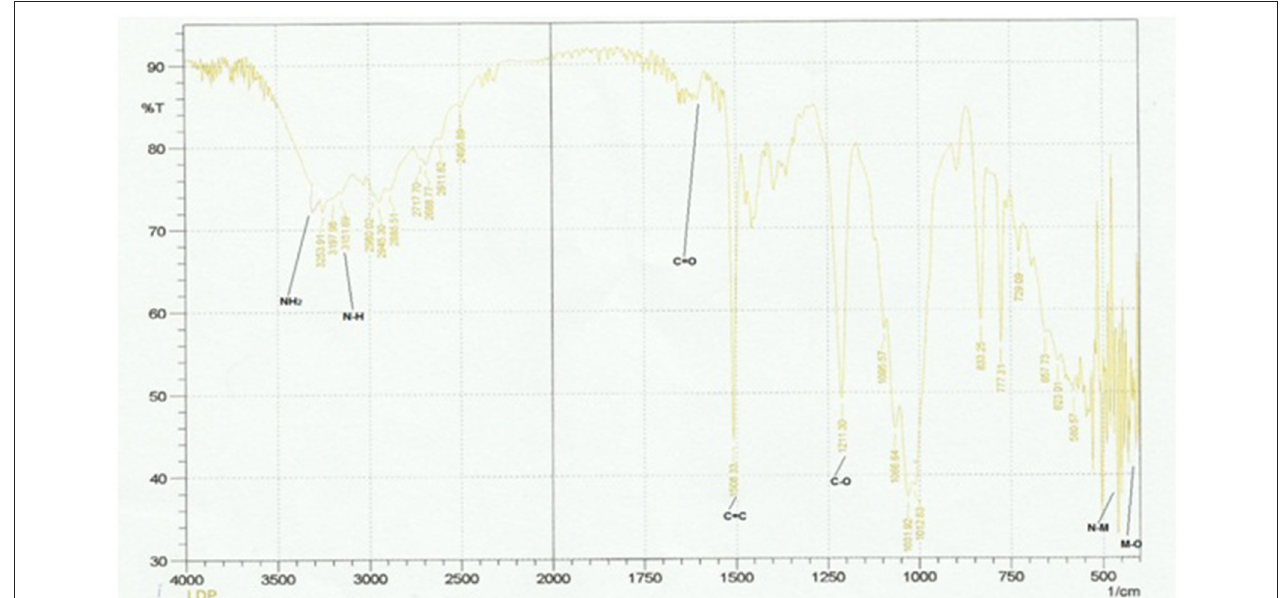
FIGURE 4 | IR spectrum of diphenyltin